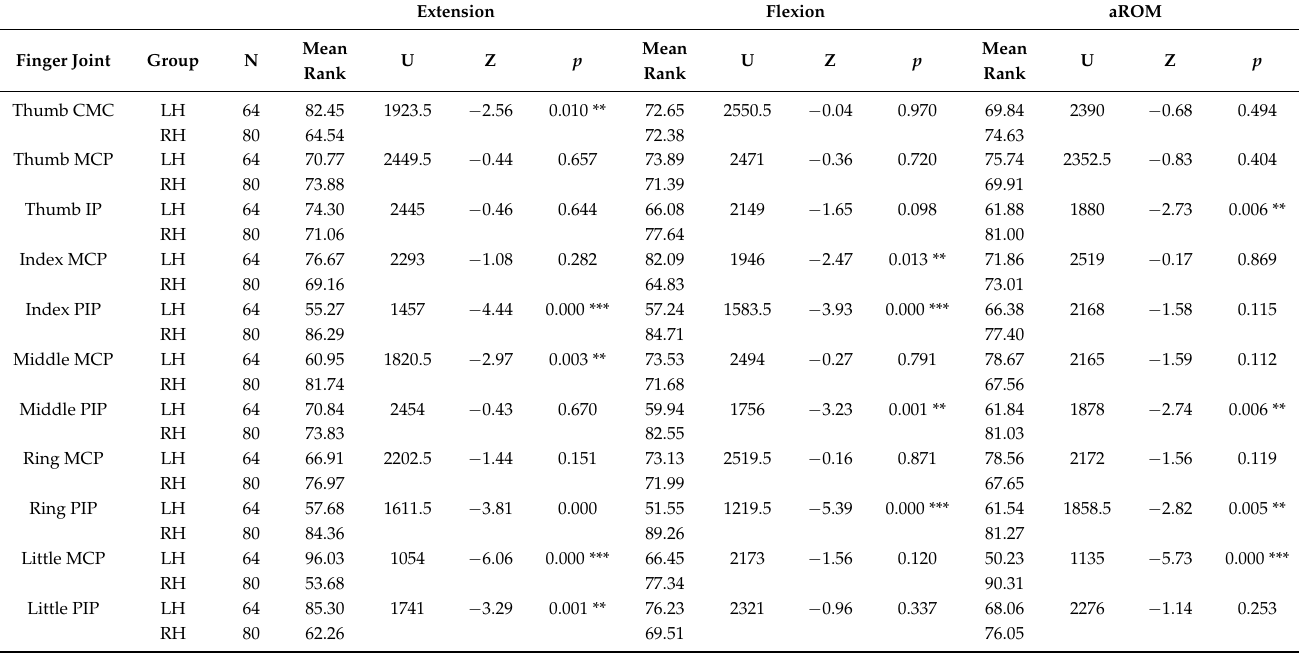
Table 8. Results of Mann–Whitney test of the ROM with respect to the stroke groups